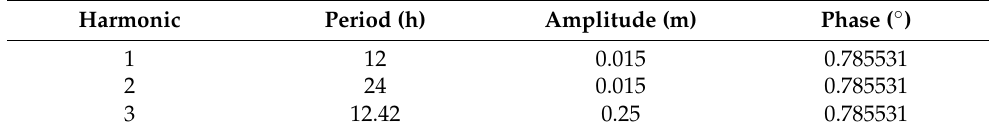
Table 3. Harmonics for adding tidal amplification in hydrodynamic modeling. Harmonic Period